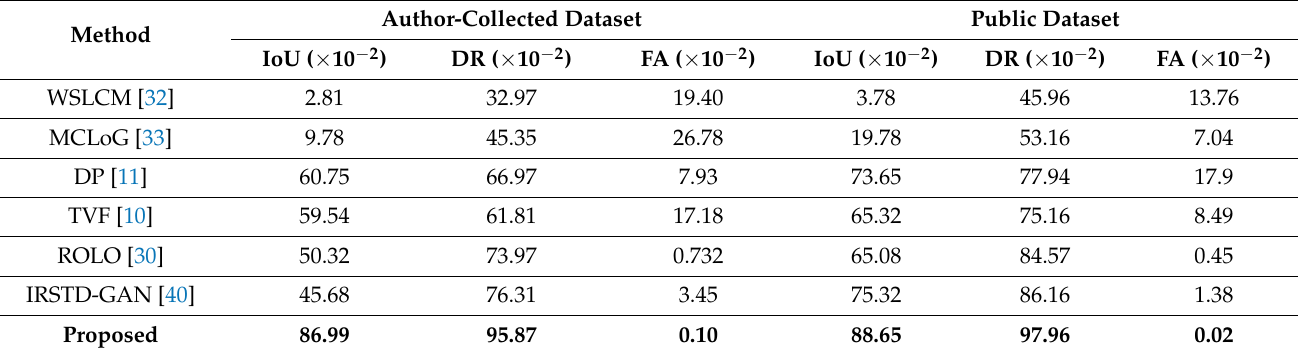
Table 4. We compute IoU, DR, and FA on public dataset and author-collected dataset with different SOTA methods. For IoU and DR, a higher value means better results. However, a smaller value of FA means that the approach works better. The best results are shown in